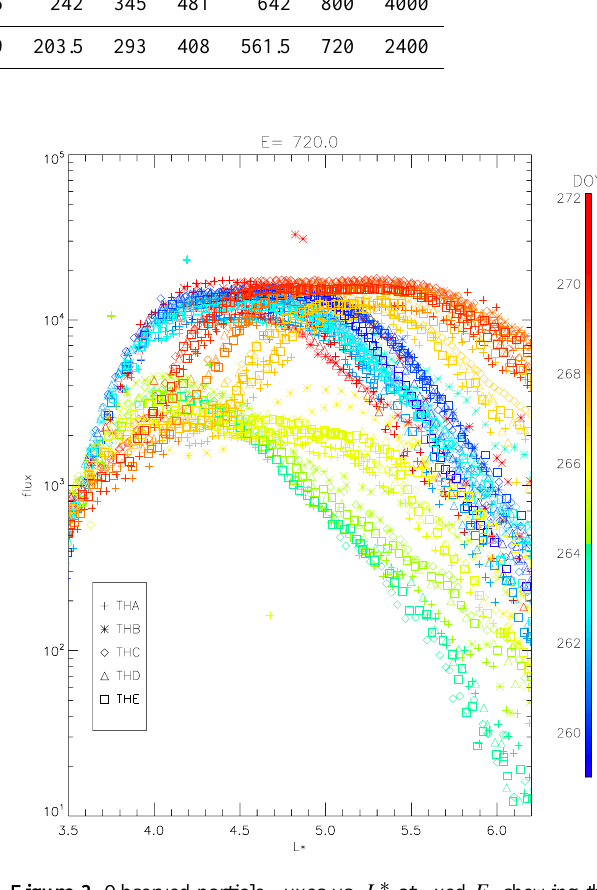
Figure 3. Observed particle fluxes vs. L ∗ at fixed E , showing the time